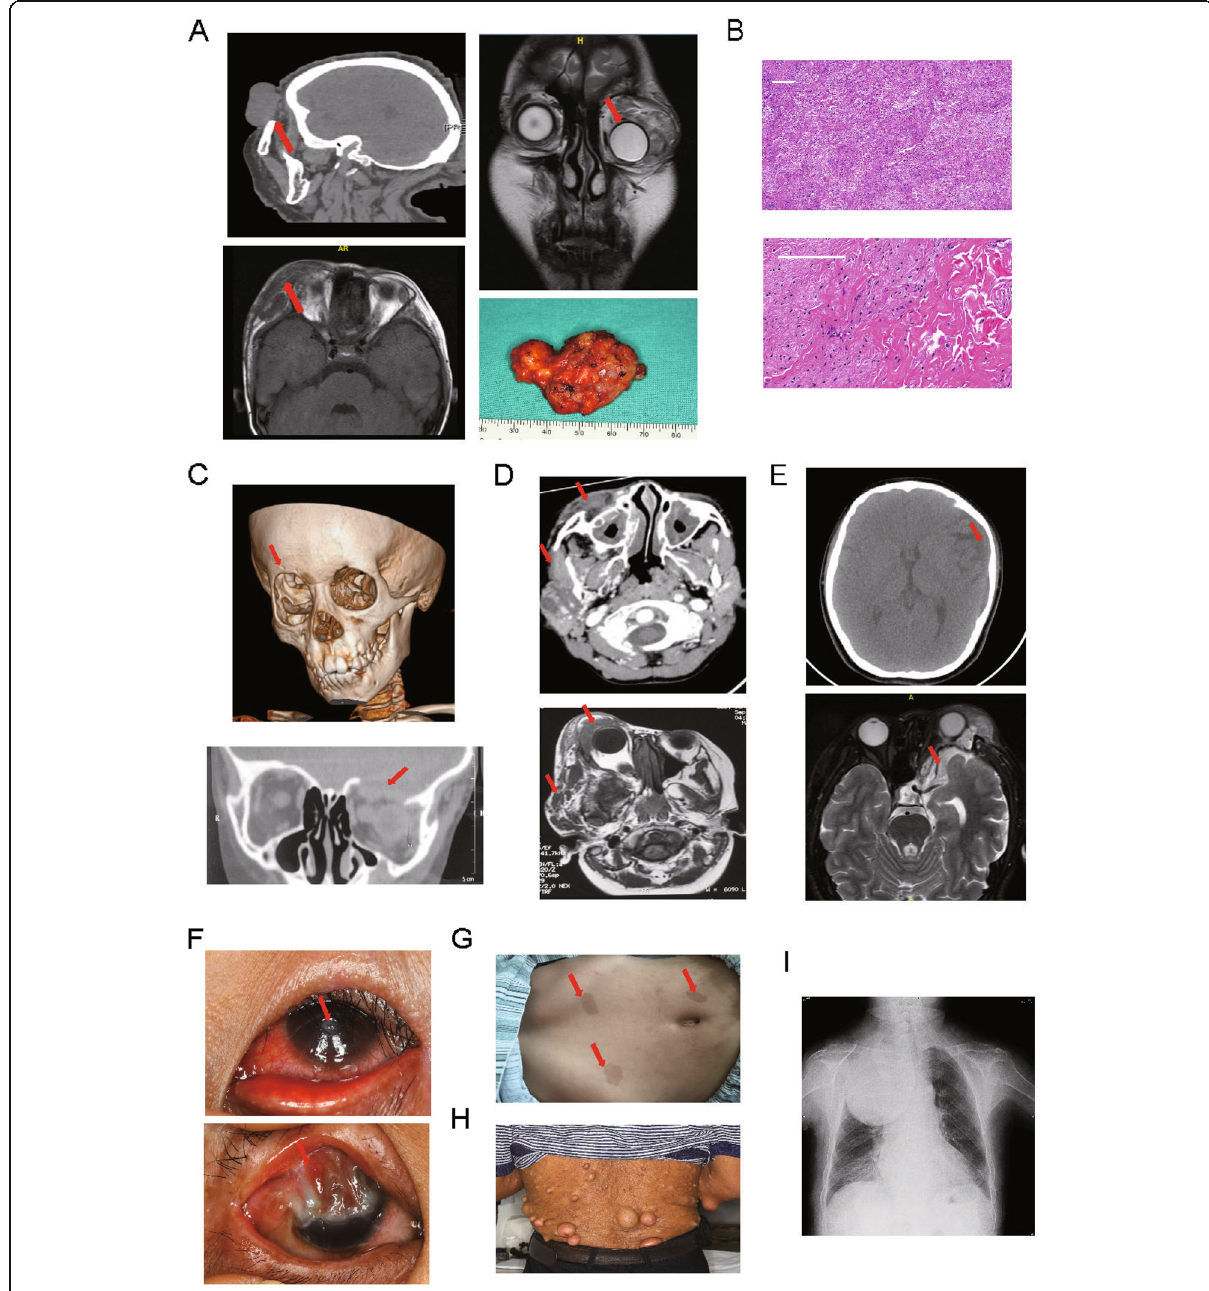
Fig. 2 Clinical manifestations of orbital/periorbital plexiform neurofibromatosis (OPPN) patients. a OPPN located in the upper eyelid. Left: Computed tomography (CT) of infiltrative OPPN. Right upper: Magnetic resonance imaging (MRI) of infiltrative OPPN. The arrow indicates the orbital infiltration of OPPN and displacement of the orbital contents. Right below: General view of a dissected OPPN. b Pathological feature of OPPN: abundant collagen fibres and nerve sheaths. Scale bar: 40 μ m. c CT images of OPPN resulting in orbital bone destruction. The arrow indicates the area of orbital osteoclasia. d CT images of facial infiltration of OPPN. The arrow indicates the infiltrated area of OPPN. e CT images of intracranial infiltration of OPPN. The arrow indicates the intracranial infiltration. f Upper: corneal ulceration. Below: Surgery-induced symblepharon. g Café au lait spots. h Coexisting extraocular OPPN. i X-ray images showing an enormous mass in the right chest of OPPN